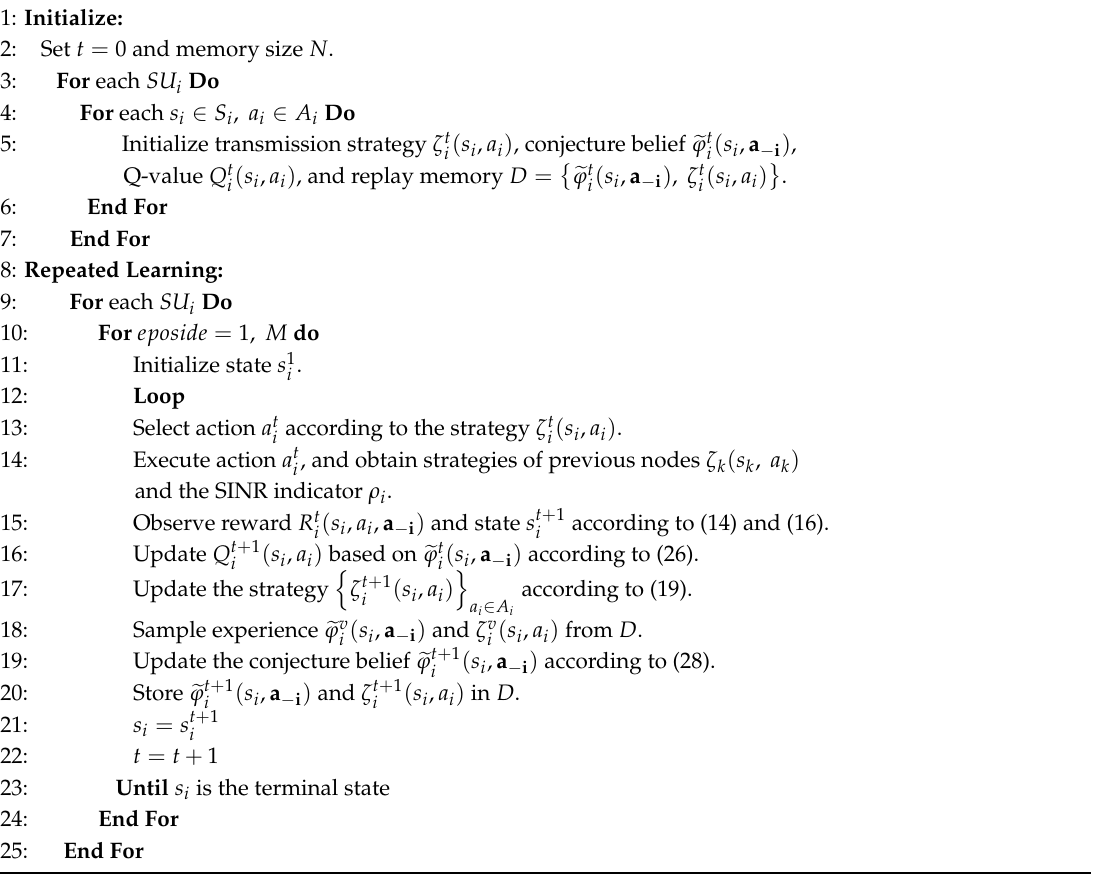
Algorithm 1 Equal Reward Time-Slots Based Conjectural Multi-Agent